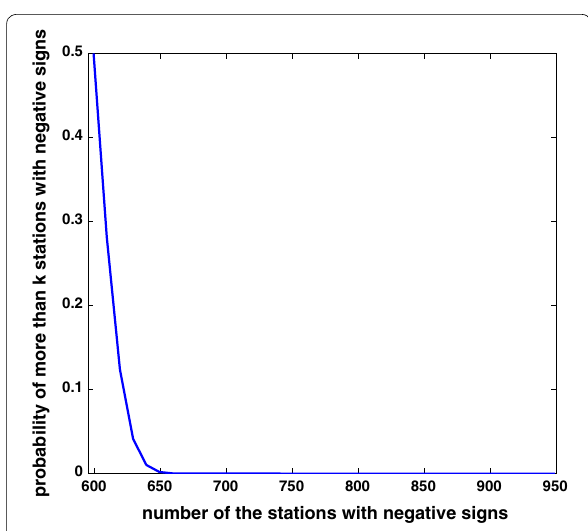
Fig. 5 Probability for k vertical displacements to have the negative sign over the whole GEONET network